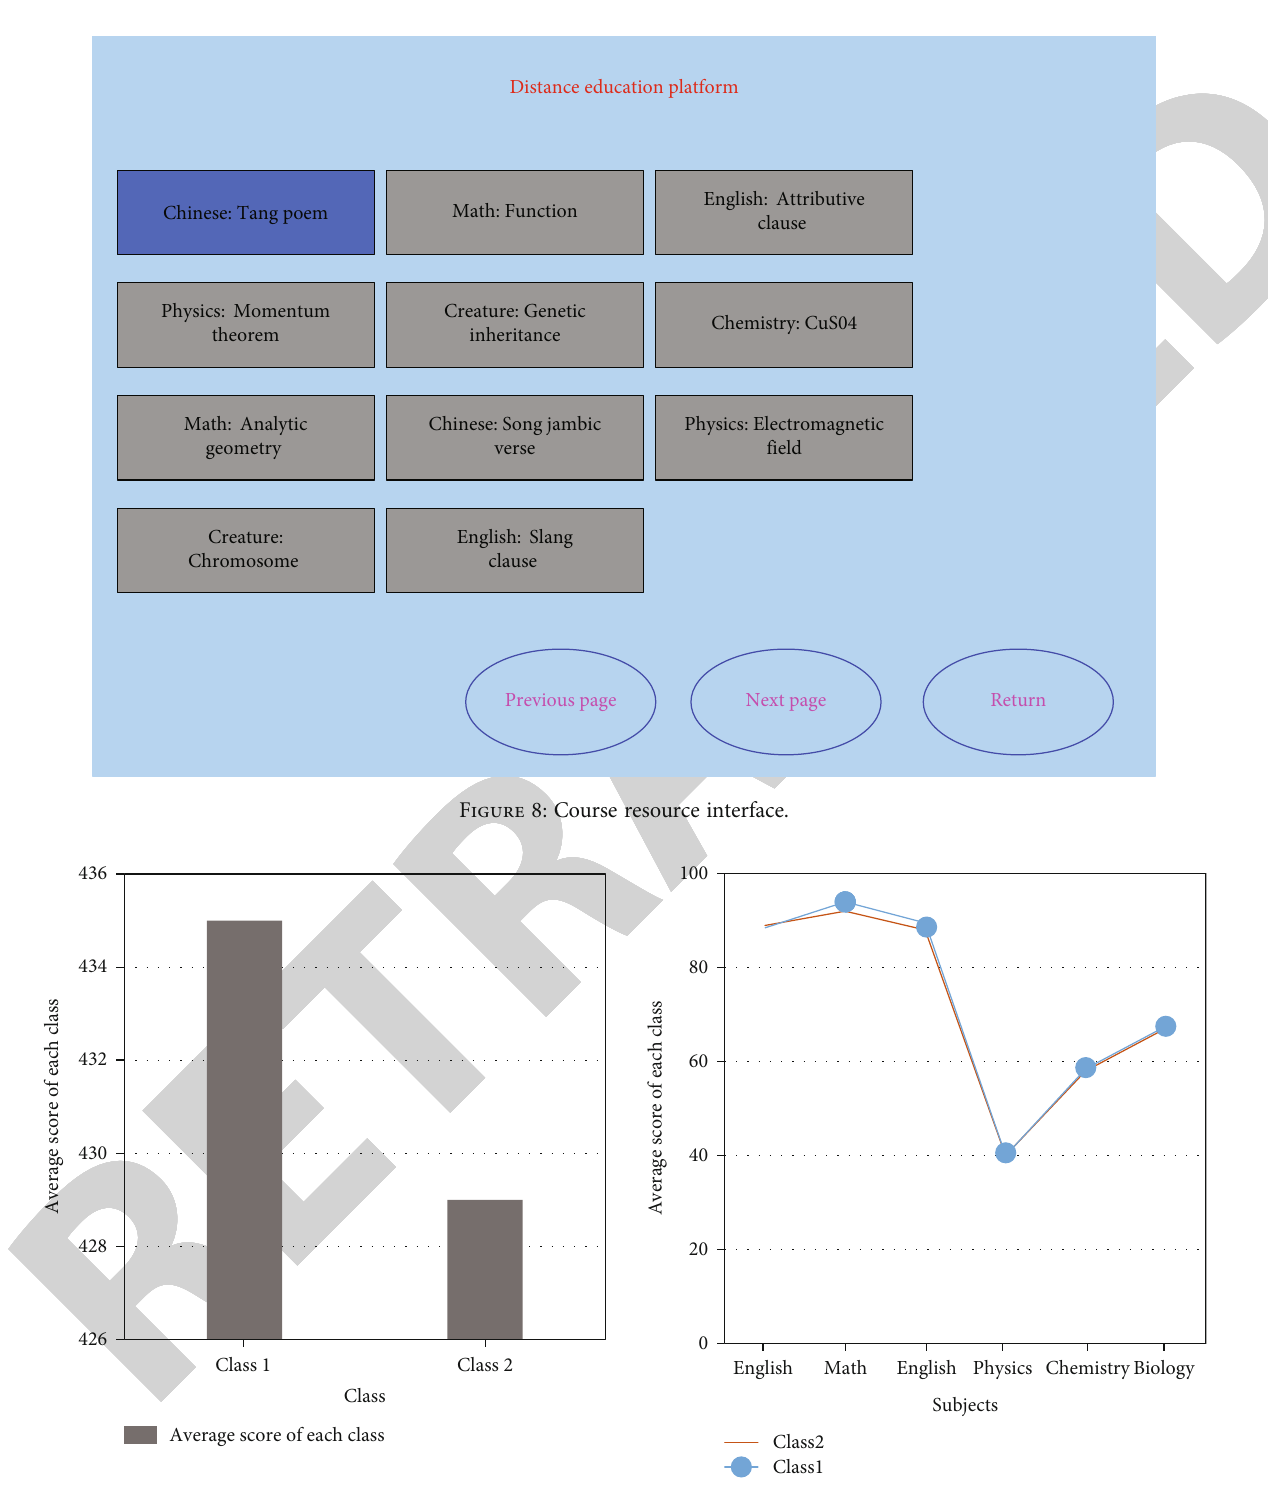
Figure 9: The average scores of the whole class and the subjects in the fi nal exam of senior